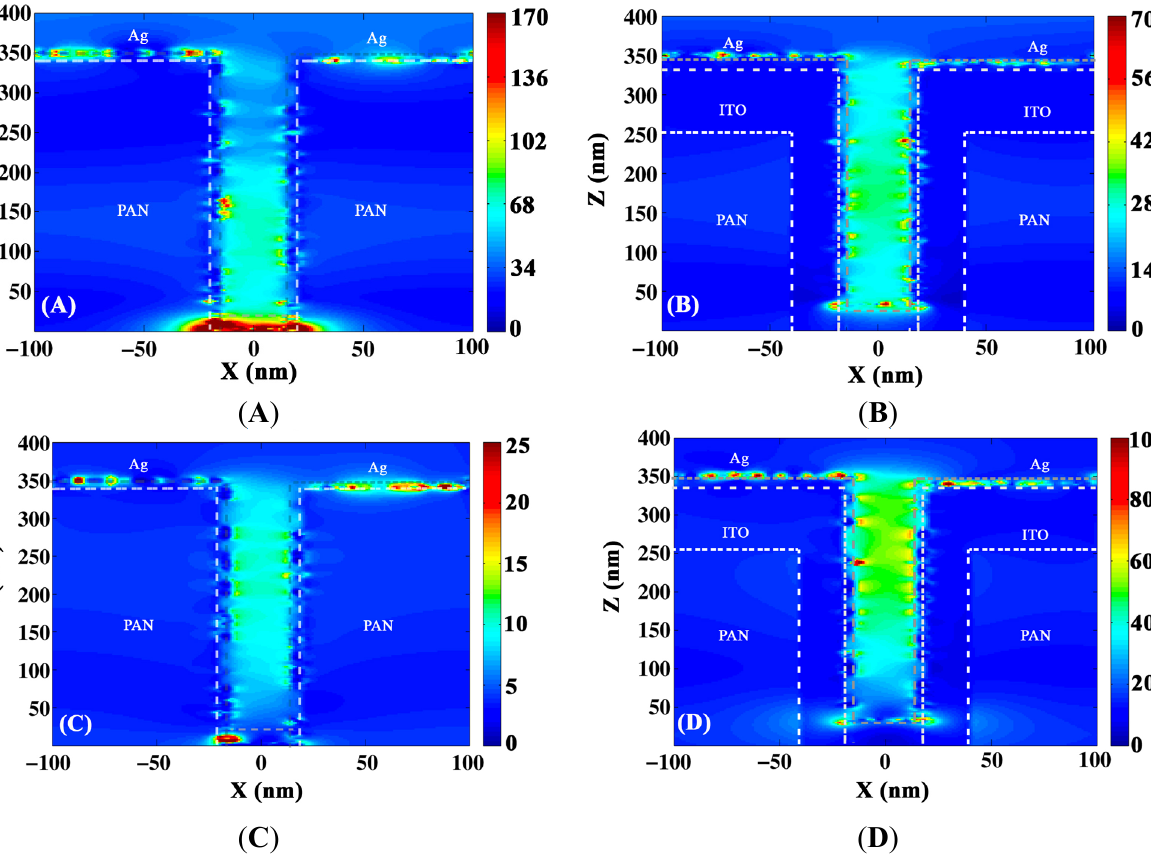
Figure 8. Comparison of electric field intensity in PAN/Ag and ITO/Ag nanoshells at 690 nm ( A and B ) and 1150 nm ( C and D